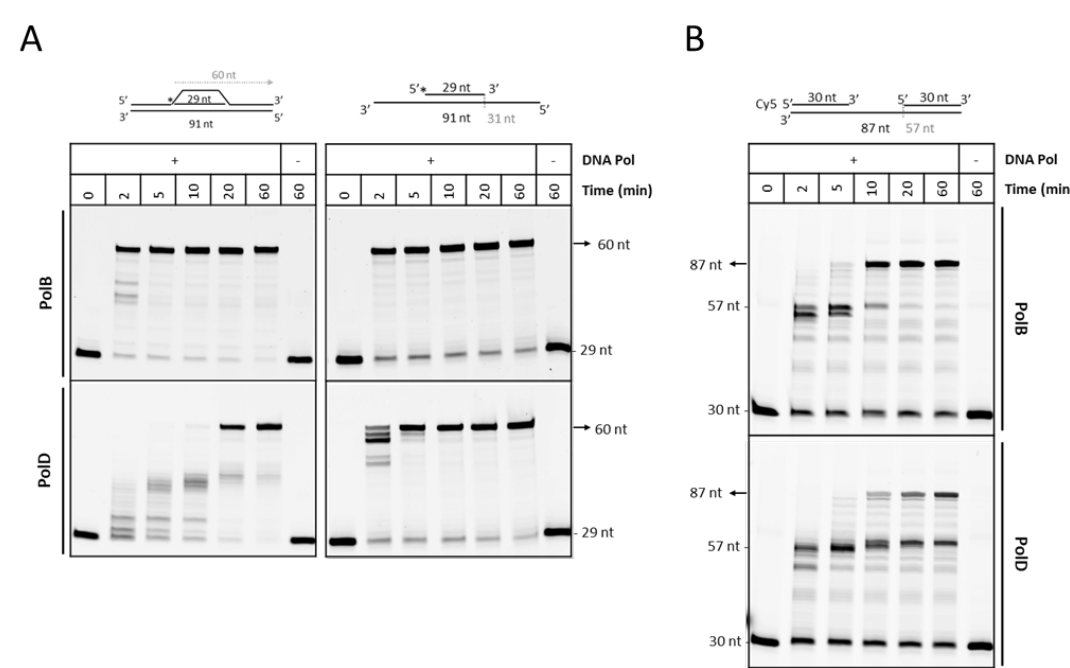
Figure 3. DNA synthesis activity of PolB and PolD on linear substrates. ( A ) Kinetics of reaction for extension of the 5′ end labeled 29 nt for the linear D-loop S91/29/30 or primer/template S29/91. ( B ) Strand displacement activity of DNA polymerases. A quantity of 225 nM of PolB or PolD was incubated with 25 nM synthetic linear DNA substrates at 65 °C for a range of time indicated. DNA products were separated by gel electrophoresis onto a 15% denaturing acrylamide gel and revealed by fluorescence.